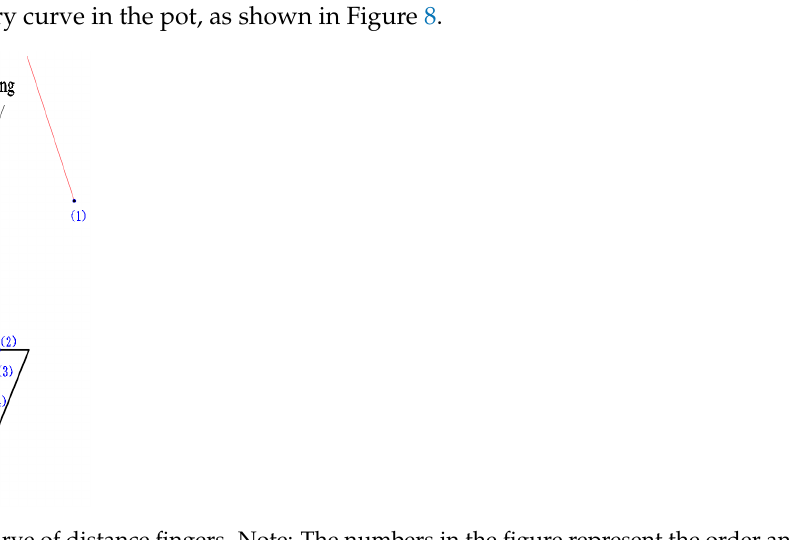
Figure 8. Trace curve of distance fingers. Note: The numbers in the figure represent the order and position of the finger’ end point. position of the finger’ end